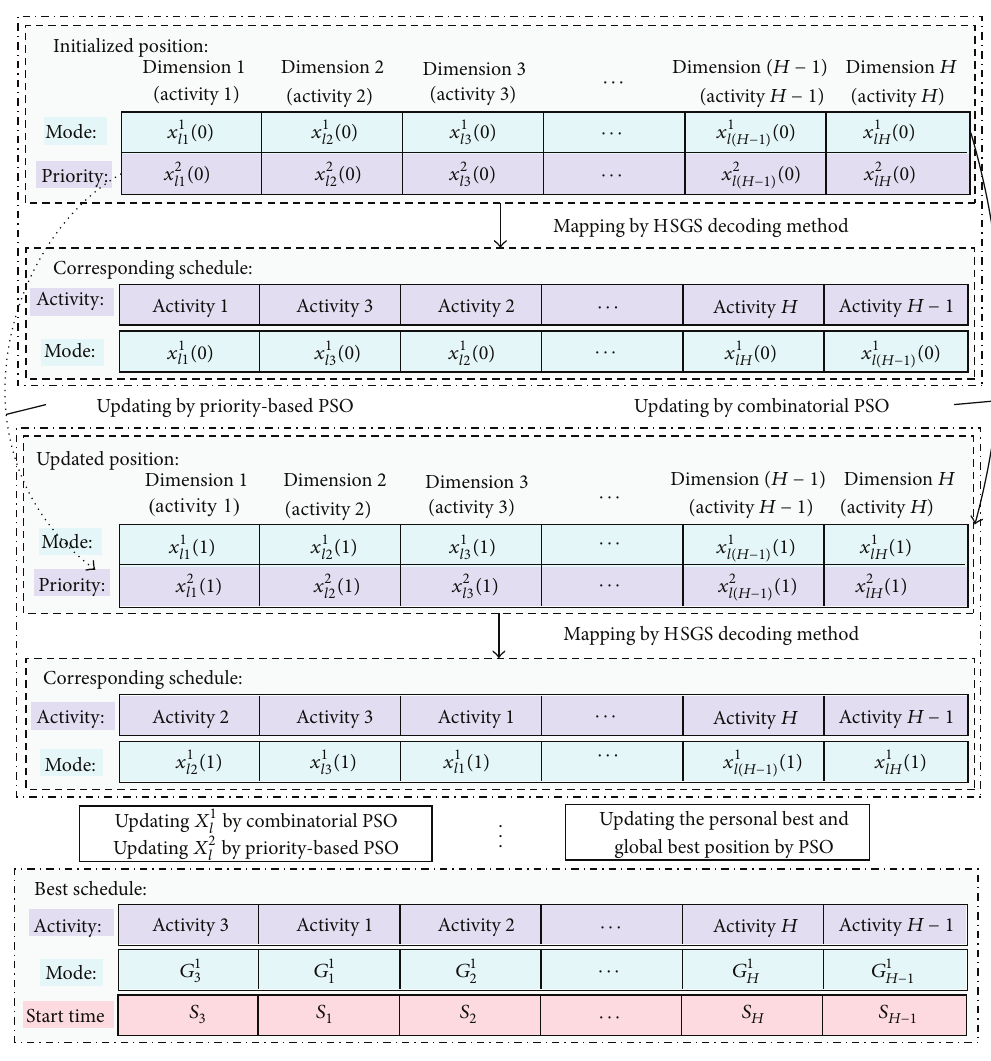
Figure 3: Transformation procedure of the CP-based